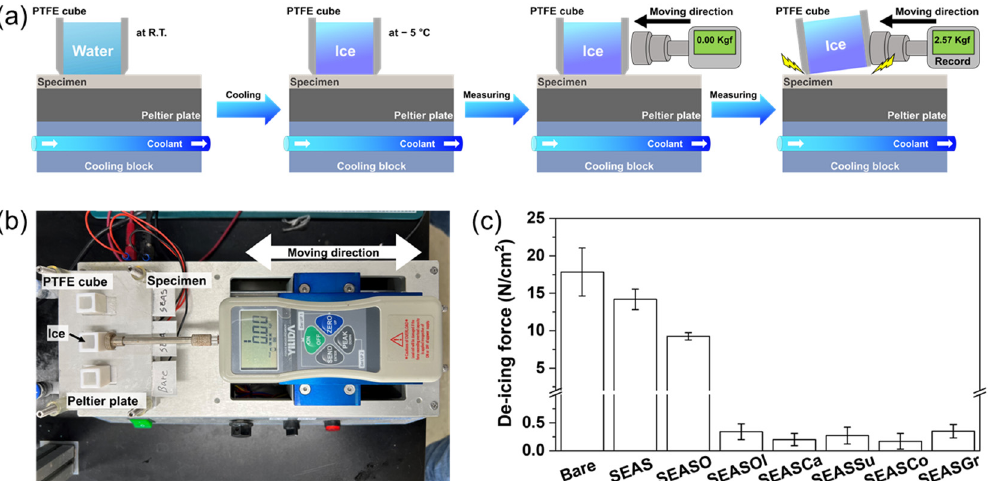
Figure 4. ( a ) Schematic images of measuring process for de-icing force. ( b ) Measurement setup for de-icing force, and ( c ) de-icing force on stainless steel surfaces with various treatments. Since the omniphobic lubricant-infused porous surface is introduced, its anti-bioufouling and inhibition of biofilm formation have been widely explored [22,41,42]. The bacterial medium is immiscible to the infused lubricant; thus, the bacterial attachment and formation of biofilm are significantly inhibited. We also tested such anti-bacterial performance of the edible oil-impregnated surface by incubating Pseudomonas aeruginosa on surfaces for 24 h. Crystal violet was used to stain the attached biofilm cells on surfaces; then, the optical density (OD) of the stained bacterial solution was measured at 570 nm. Figure 5 shows the images of stained bacterial solution with the sample and measured OD at 570 nm for crystal violet absorbance, which is proportional to the attached biomass. The OD of bare SS304 is 3.21, and it decreased to 2.09 by anodic oxidation. Further decrease of OD to 1.71 was shown for hydrophobized anodic oxide. Such reduction in biofilm is attributed to a decrease in surface area by anodic oxidation and adhesion force by hydrophobizing with the low-surface-energy material [43]. Contrary to our expectations, the oleic acid-impregnated surface (SEASO) showed ~10% higher OD (3.53) than bare SS304. The membrane forming the cell of Pseudomonas aeruginosa has a similar molecular structure with oleic acid, which is monosaturated fatty acid; thus, the Pseudomonas aeruginosa adheres better upon contact with oleic acid. Thus, the Pseudomonas aeruginosa was more cultivated on the oleic acid- impregnated surface. However, the edible oils also include linoleic acid, which is known to inhibit biofilm formation under static and continuous conditions without inhibiting the growth of Pseudomonas aeruginosa [44]. Therefore, the edible oil-impregnated surface shows significantly reduced OD less than 0.2, which indicates the inhibition of biofilm formation by more than 93.8% compared to bare SS304. Comparing to SEAS, which is a hydrophobic nanoporous surface, more than 88.3% of biofilm formation is reduced by the edible oil- impregnation. Such reduction in biofilm formation by the edible oil-impregnation is less significant than the perfluorinated lubricant (i.e., Krytox oils), which showed more than 95% reduction for Pseudomonas aeruginosa , Staphylococcus aureus , and Escherichia coli [45]. These difference in anti-biofouling performance is attributed to the composition of edible oil containing oleic acid, which allows the adhesion of bacterial to oily surfaces. Nevertheless, it should be noted that the edible oil also contains linoleic acid, which inhibits the biofilm formation, and the oily surface is immiscible to an aqueous medium; thus, the edible oil-impregnated nanoporous surface has an anti-biofouling